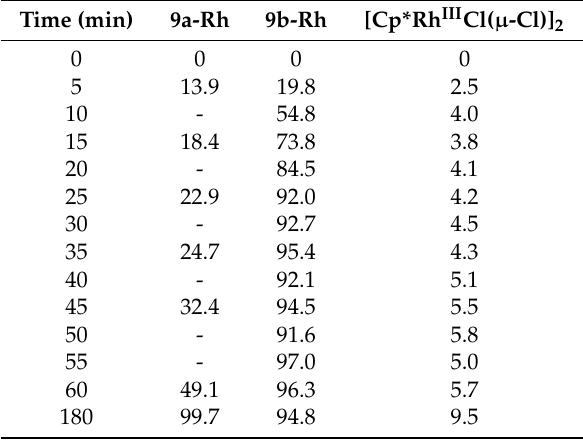
Table 3. Yields (%) of product over time (min) using 9a-Rh , 9b-Rh , or [Cp*Rh III Cl( µ -Cl)] 2 [a] . Time (min)